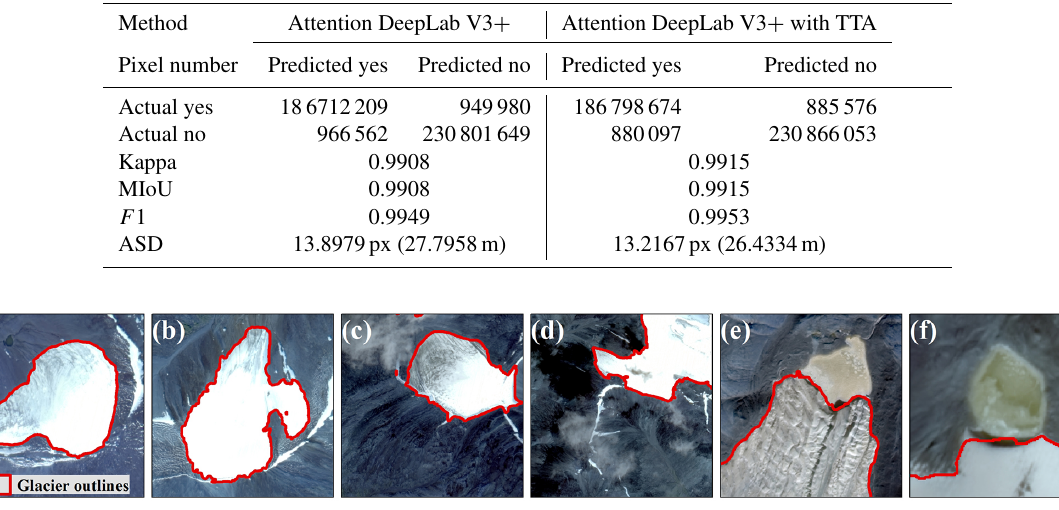
Figure 17. Examples of results in different situations. Panels (a) and (b) are the thin snow-covered, (c) and (d) the cloud-covered, and (e) and (f) the terminal moraine